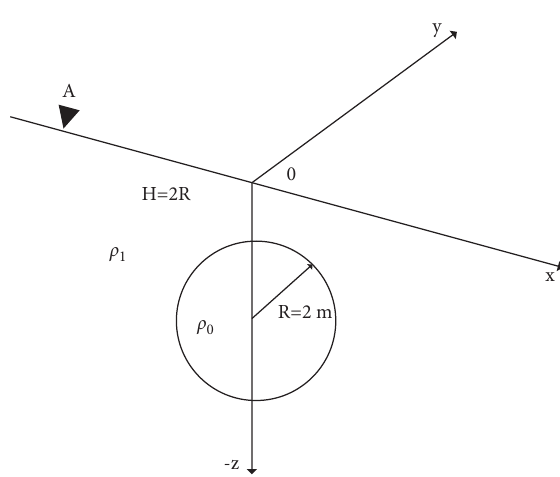
Figure 1: The geometric structure of the sphere